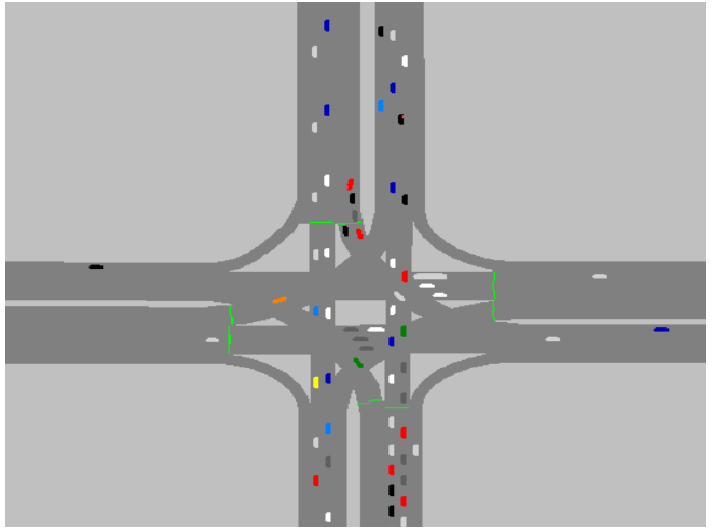
Figure 6. Schematic diagram of traffic scene simulation.